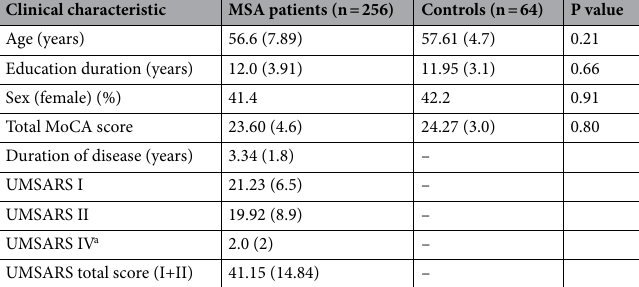
Table 1. Demographic data and clinical characteristics of MSA patients and controls. Data are expressed as mean (standard deviation). a The data are expressed as median (interquartile range).